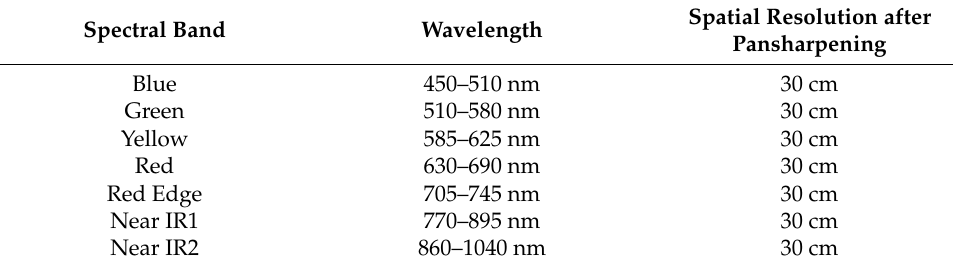
Table 1. The bands of WorldView-3 imagery used in the research.